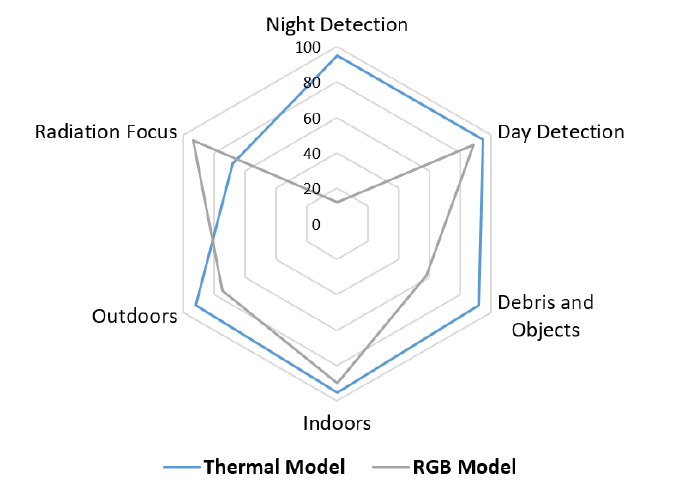
Figure 16. Percentage comparison of efficiency of the analyzed methods (Thermal and RGB). Source: